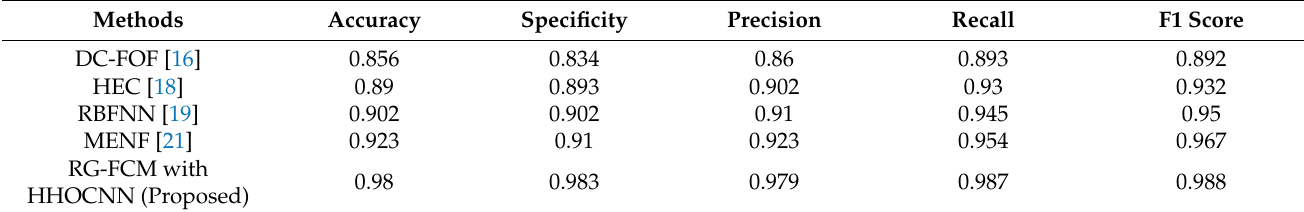
Table 3. Brain Tumor Segmentation